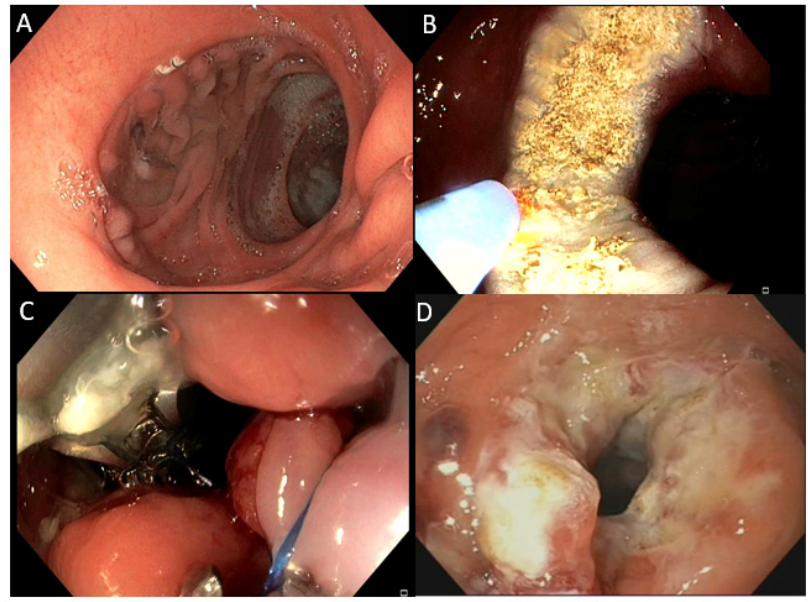
Figure 1. Transoral outlet reduction of the GJA in RYGB: ( A ) enlarged GJA anastomosis; ( B ) cauteri- zation with APC; ( C ) suturing with Apollo Overstitch; ( D ) final